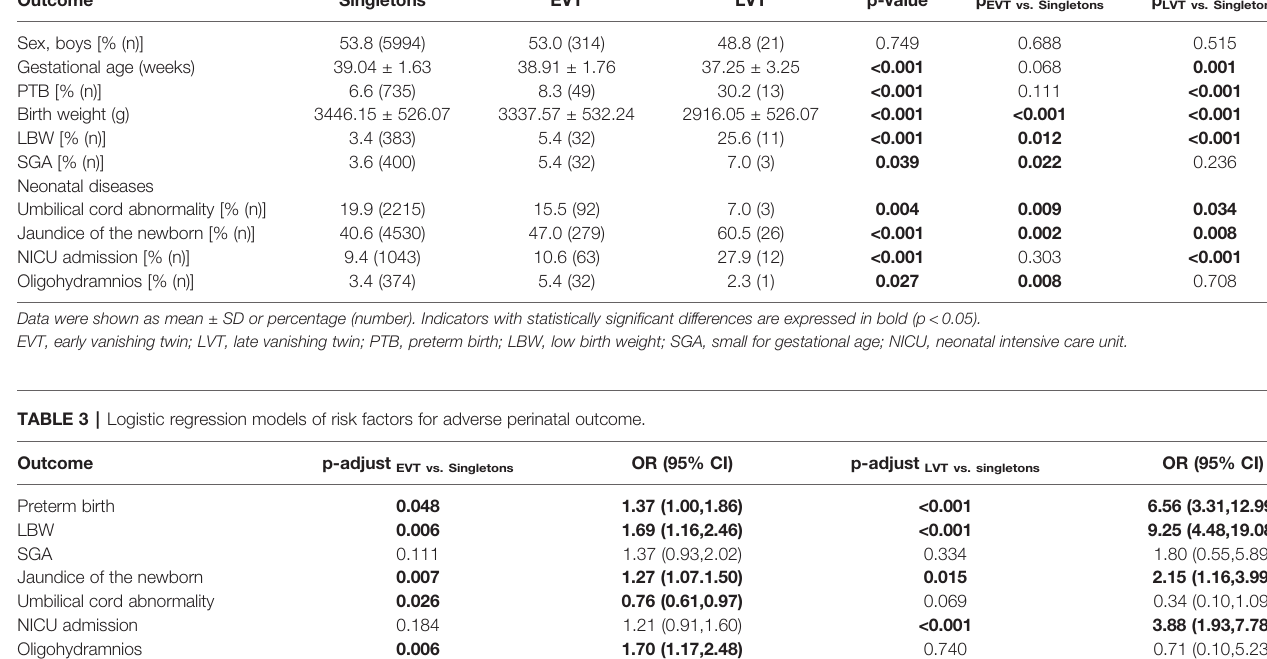
TABLE 2 | Perinatal outcomes of singleton, EVT, and LVT births. Outcome Singletons EVT